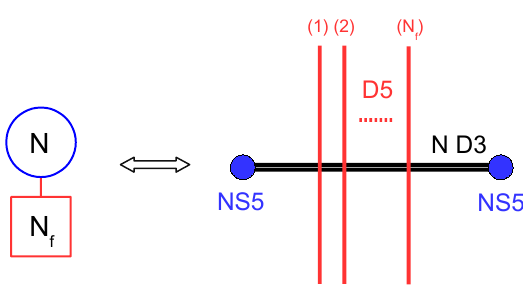
Figure 34 . Quiver diagram and brane realization of U( N ) SQCD.